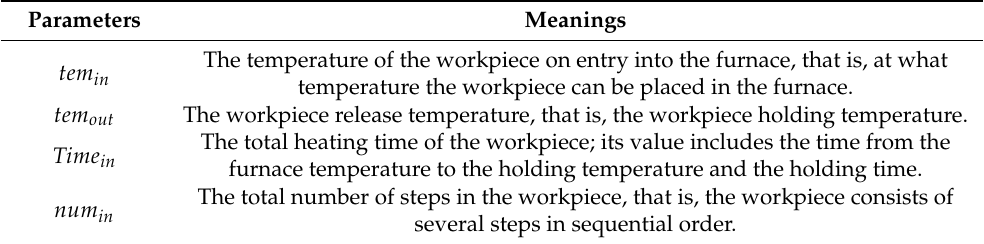
Table 1. Artifact model